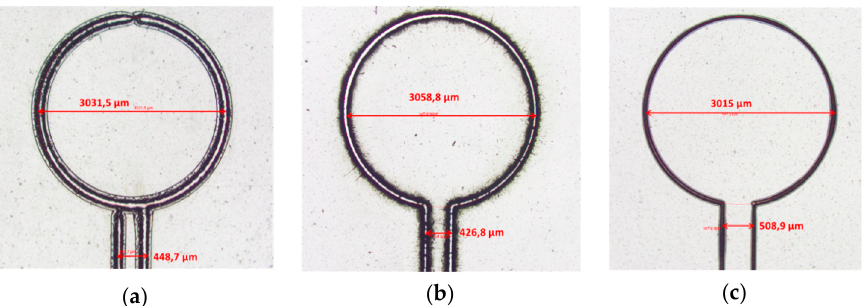
Figure 2. Microscope images of the structured receiver on the tape using ( a ) 200 µm spot CO 2 laser; ( b ) 50 µm spot pulsed green laser and ( c ) 10–30 µm spot ps UV laser.